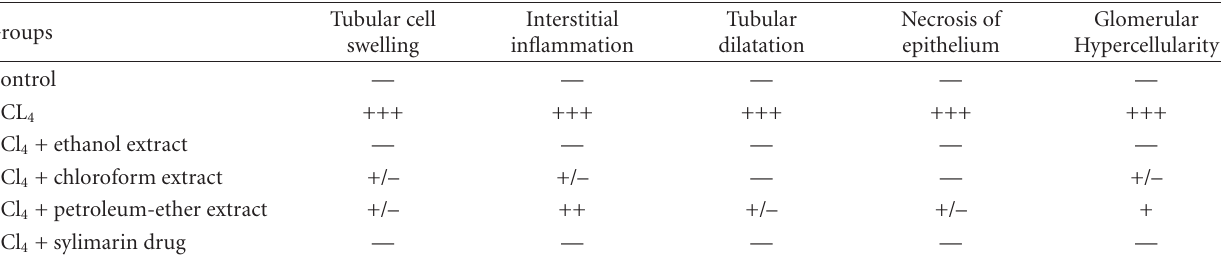
Severity of renal histological changes using scores on a scale of none (–), mild (+), moderate (++), and severe (+++)